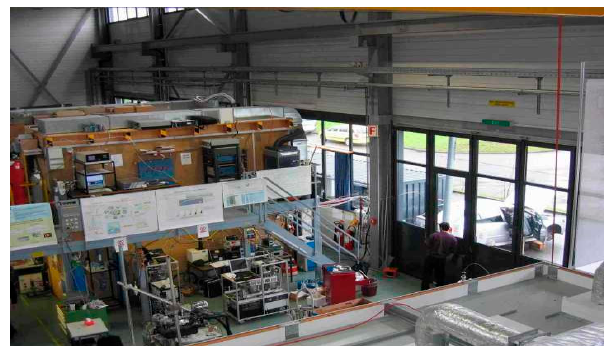
Figure 1. Example of Indoor Smog Chamber Configuration for the study of gas and aerosol photochemistry. CE-CERT, University of California Riverside System and the US Environmental Protection Agency (Reprinted from Carter et al., [85] with permission from Elsevier).